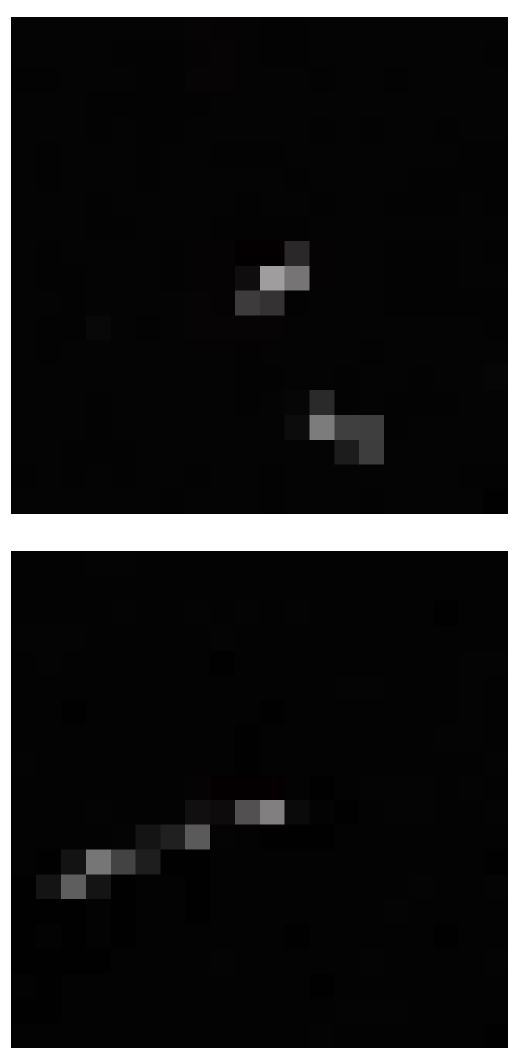
Figure 3. Examples of images taken with the completely covered camera of a smartphone using the CREDO